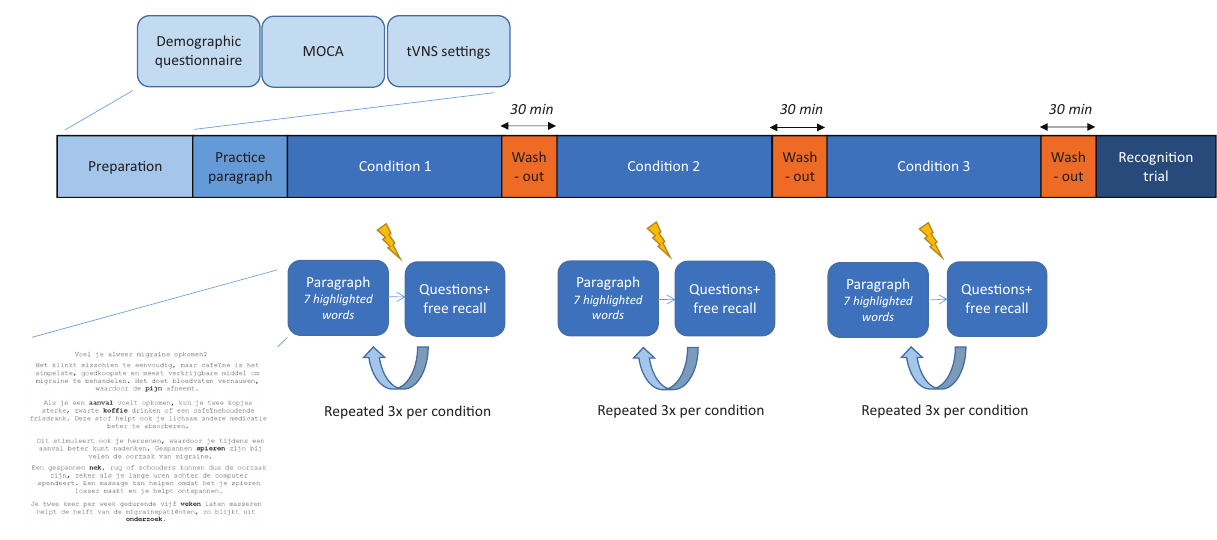
Frontiers in Psychology |